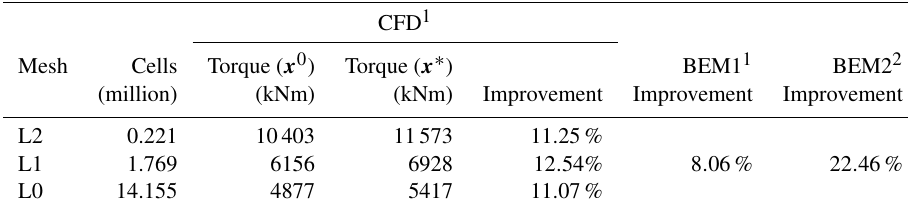
Figure 13. Comparison between optimal chord (a) and twist (b) distributions for the IEA Wind Task 37 case study. The three design optimization problems – (i) single-point planform optimization, (ii) BEM1, and (iii) BEM2 – are further described in Sect. 5.1. Table 7. Planform optimization comparison between CFD and BEM